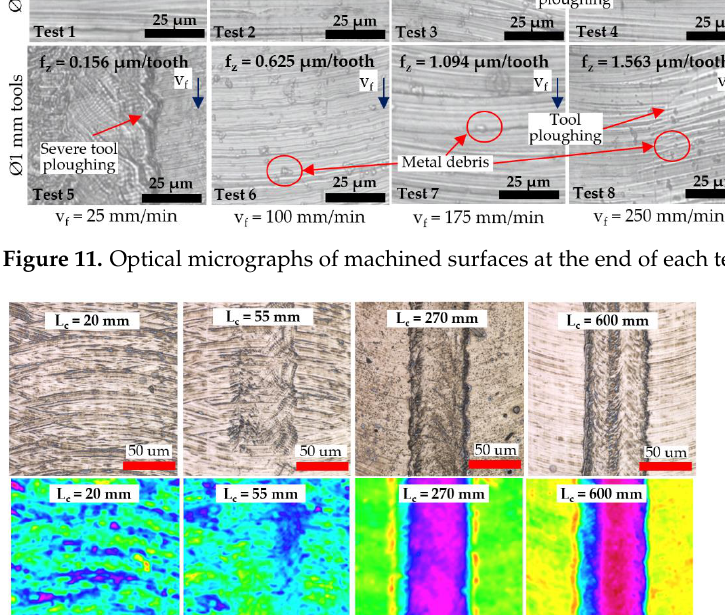
Figure 13. Micrographs of tool wear progression in Test 5. v f = 25 mm/min, f z = 0.156 µm/tooth. The results of slot surface roughness measurements against cutting length for the Ø 4 mm and Ø 1 mm tools are displayed in Figure 14a,b, respectively. In general, lower surface roughness levels were recorded when utilising the larger end-mills (0.21 – 0.46 µm